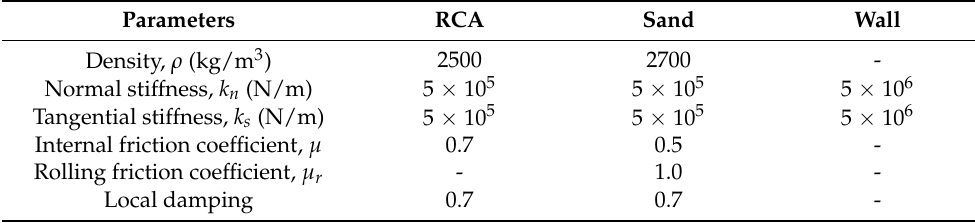
Table 2. Microscopic parameters used in this